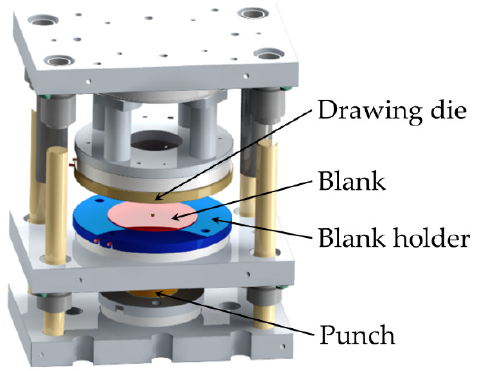
Figure 1. CAD design of the deep drawing tool used.